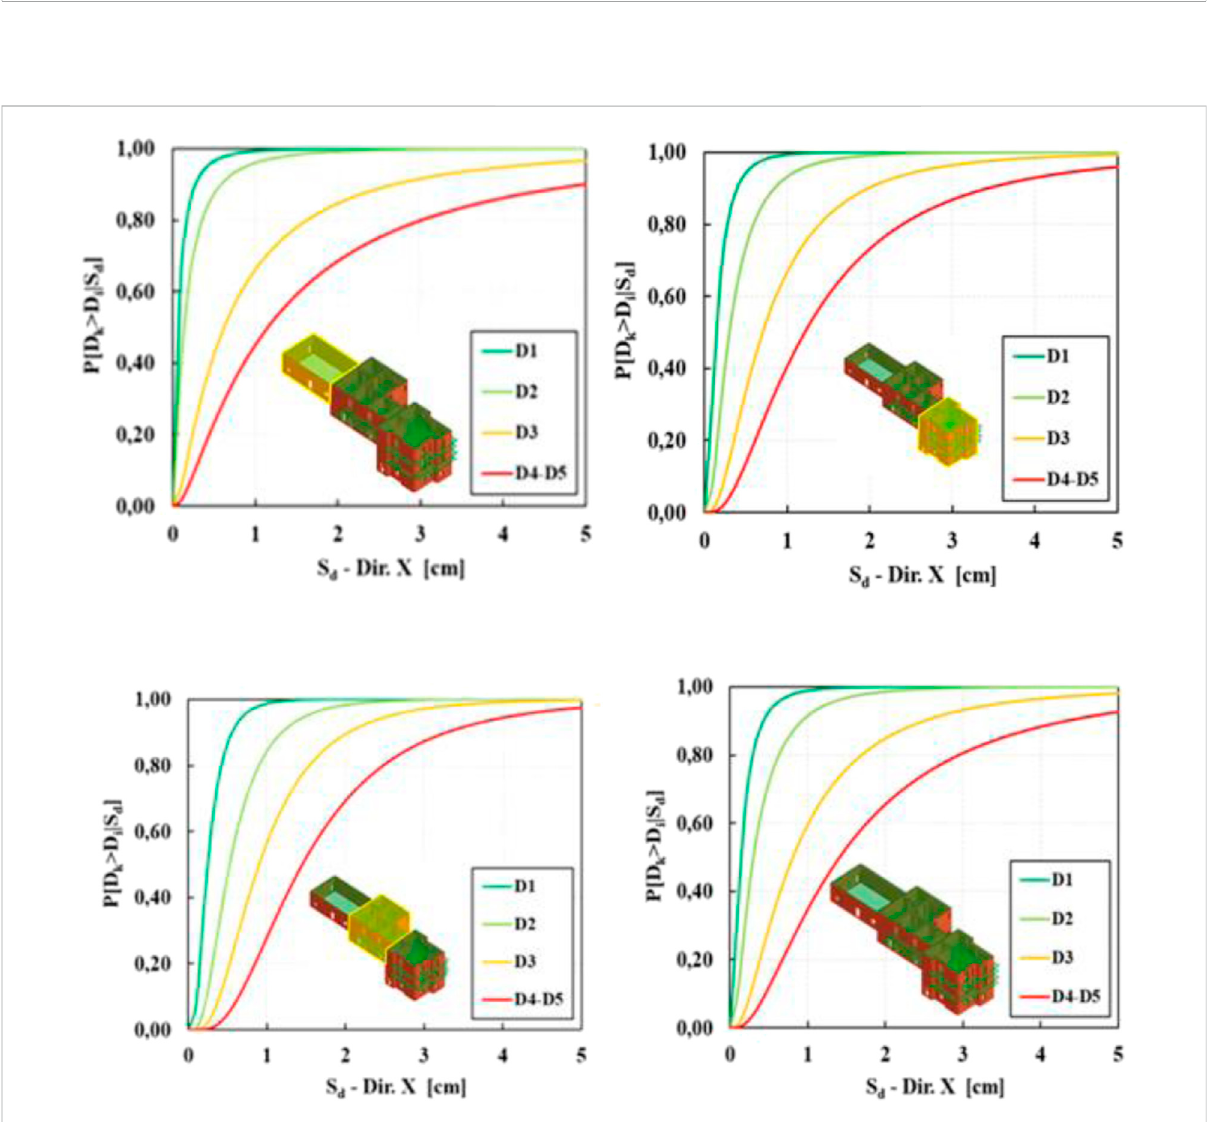
FIGURE 6 Fragility curves of SU and building aggregate in direction